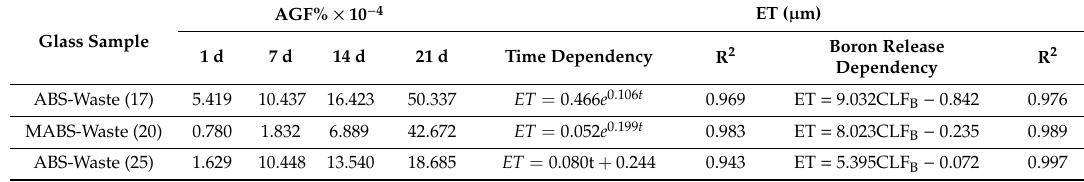
Figure 4. The evolution of glass matrix composition during the leaching process: ( a ) temporal changes in non-bridging oxygen (NBO); ( b ) The NBO fraction as a function of former fraction. Table 8. The evolution and dependency of glass degradation measures.